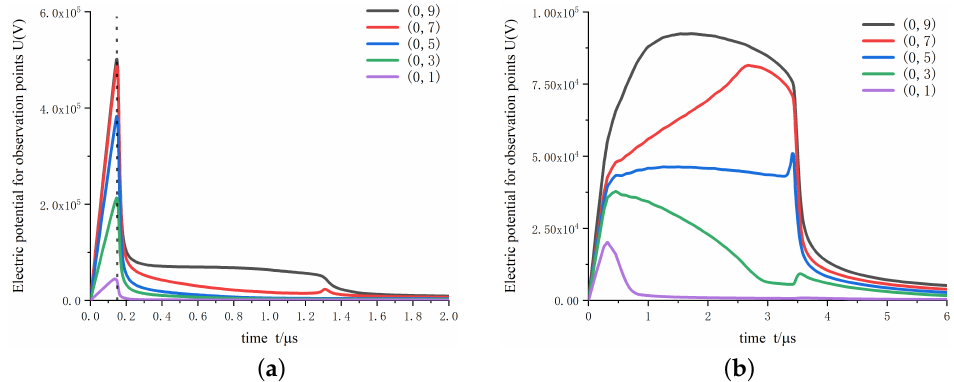
Figure 5. Electric potential change curve with time of each observation point: ( a ) Electric potential change curve in SMTS. ( b ) Electric potential change curve in the original multi-compression structure.